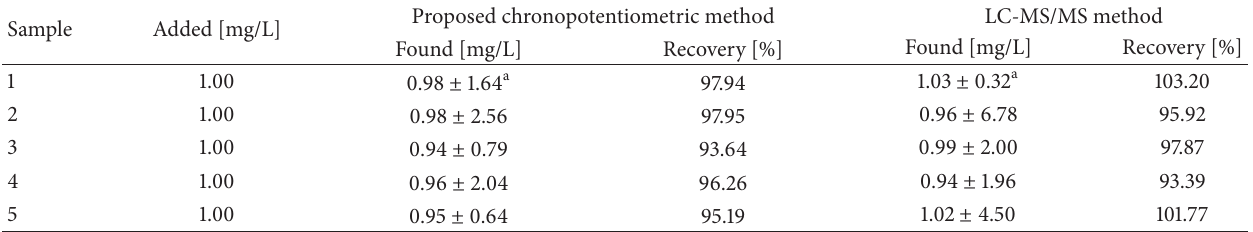
Table 4: Results obtained for the analysis of spiked river water samples by the proposed chronopotentiometric method and reference LC- MS/MS